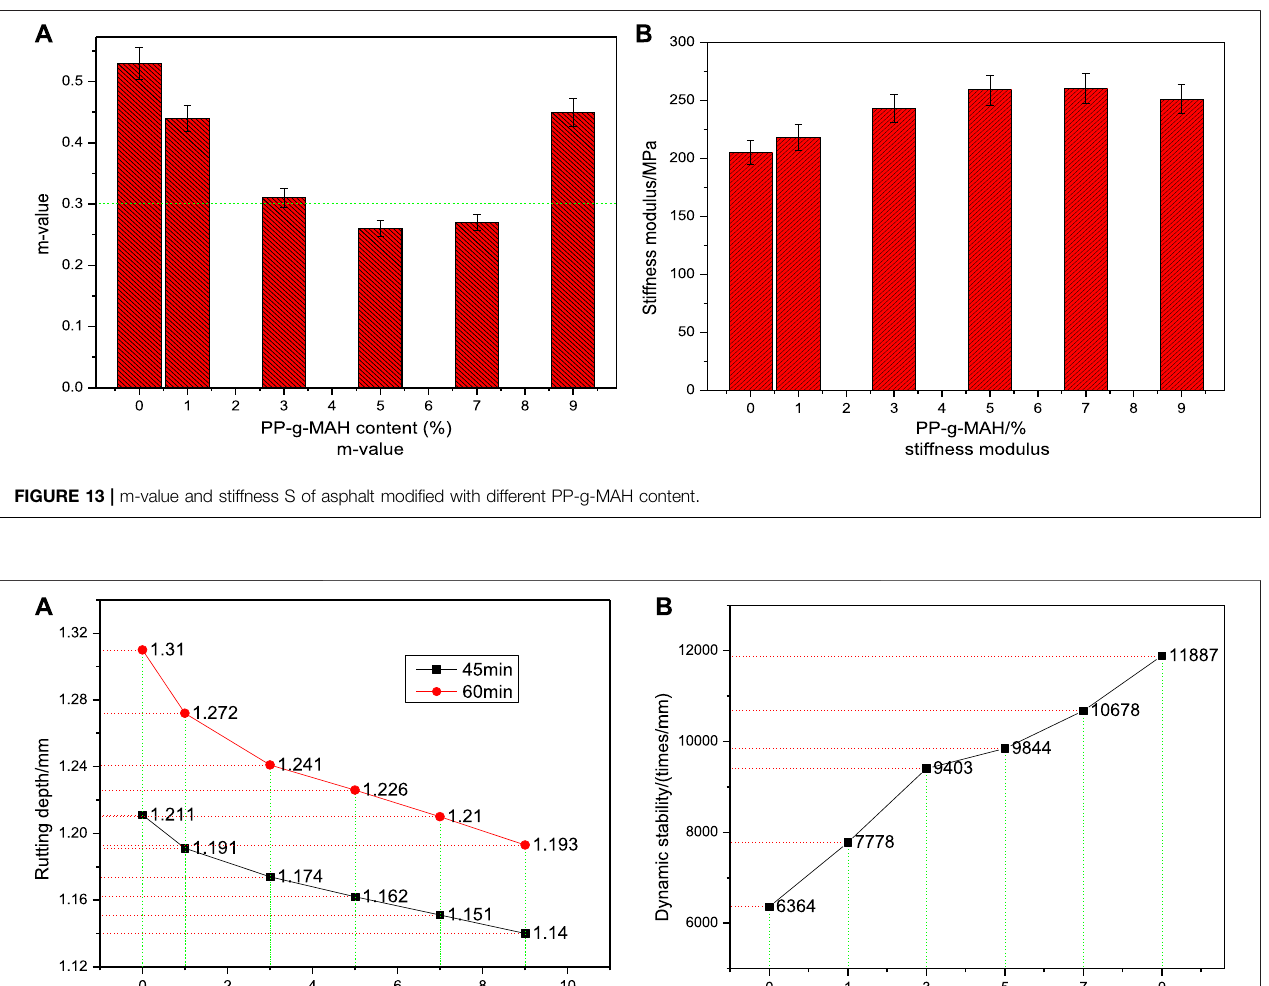
Frontiers in Materials |